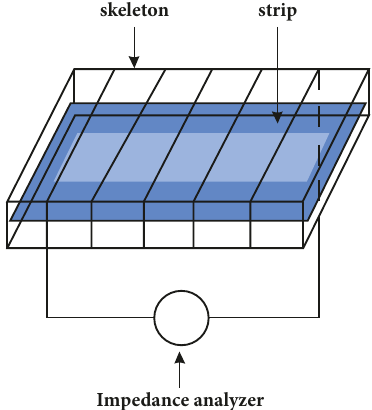
Figure 1: Scheme of testing principle of magnetoimpedance